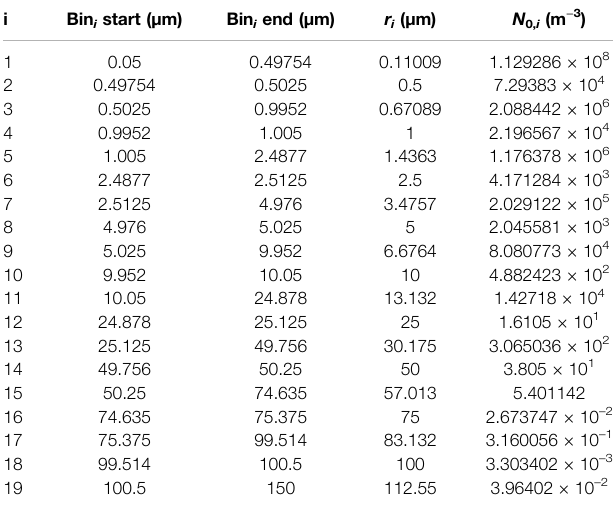
TABLE 3 | Discretization bins of the size